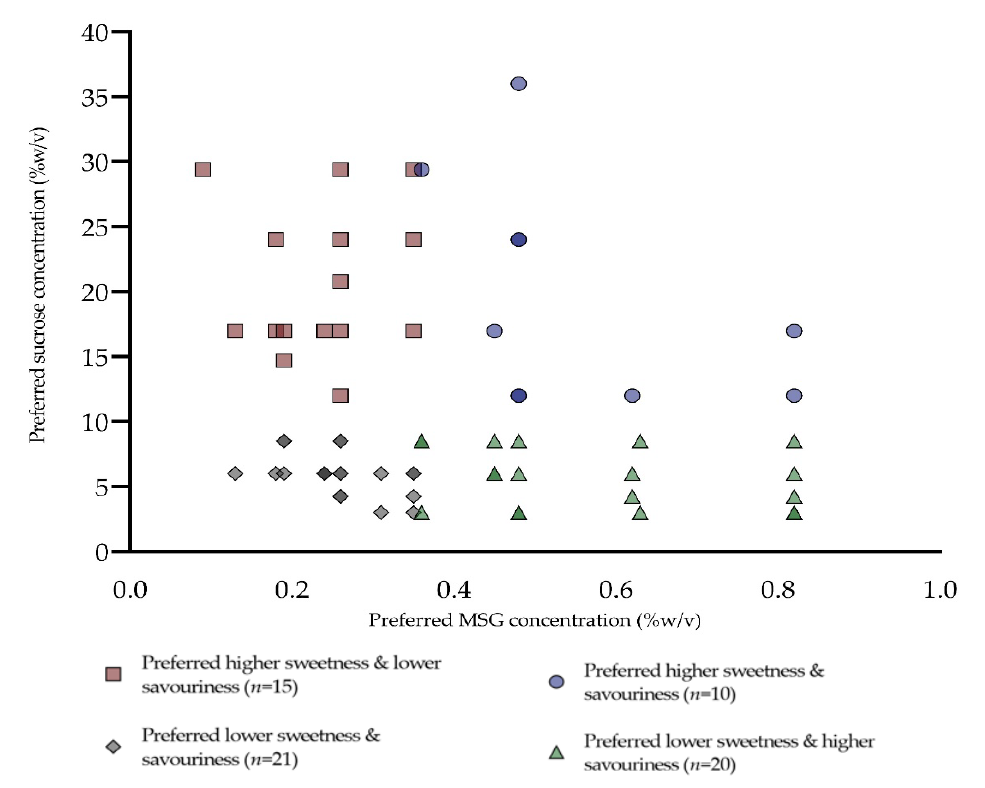
Figure 2. Distribution of participants’ sweetness and savouriness preferences based on optimum concentrations (% w / v ) of sucrose and MSG ( n = 66). Table 2. Associations between sweetness and savouriness preferences with energy intake and